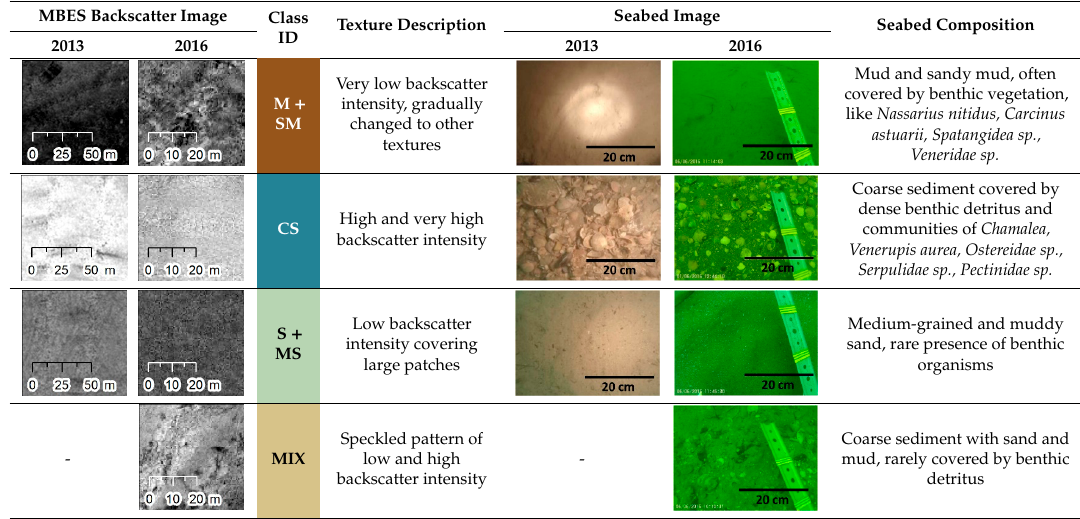
Coarse sediment with sand and mud, rarely covered by